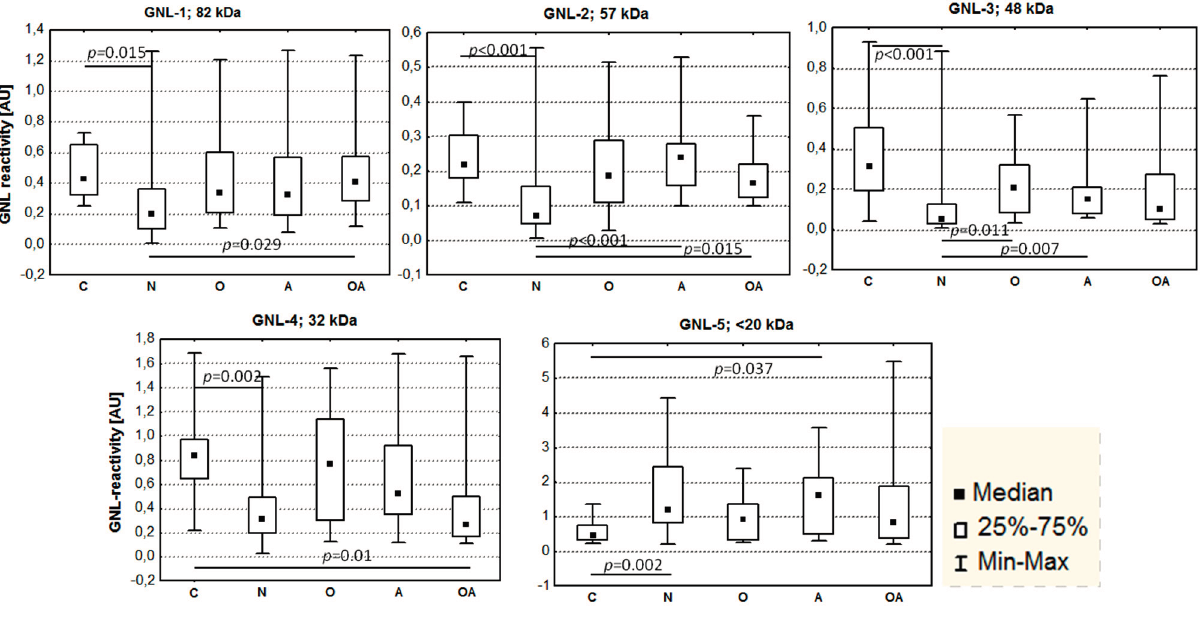
Figure 2. GNL reactivity of seminal plasma glycoproteins. Infertile patients: N— normozoospermia, O—oligozoospermia, A—asthenozoospermia, OA—oligoasthenozoospermia; C—control fertile subjects. p values in Kruskal–Wallis test represent statistical significance of the difference among the analyzed